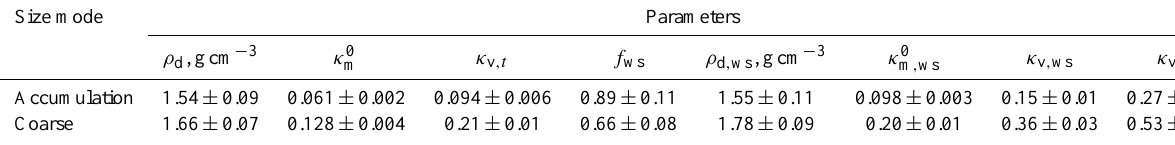
Table 5. Characteristic parameters obtained for the accumulation and coarse modes of ZOTTO samples: density ( ρ d , ρ d , ws ) (Eq. 10), KIM- derived ( κ 0 m , κ 0 m , ws ) and corresponding volume-based hygroscopicity parameters ( κ v,t , κ v , ws ) (Eq. 9), and mass fraction of water-soluble compounds ( f ws ) . Subscripts t and ws stand for parameters related to total PM and to the water-soluble fraction, respectively. κ v , p is the predicted hygroscopicity based on the ZSR mixing rule (Eqs. 15, 16). For κ 0 m , κ 0 m , ws uncertainties result from the goodness of the KIM fit. For the other parameters the propagated errors were calculated based on the total differential of a function by neglecting correlations between variables.